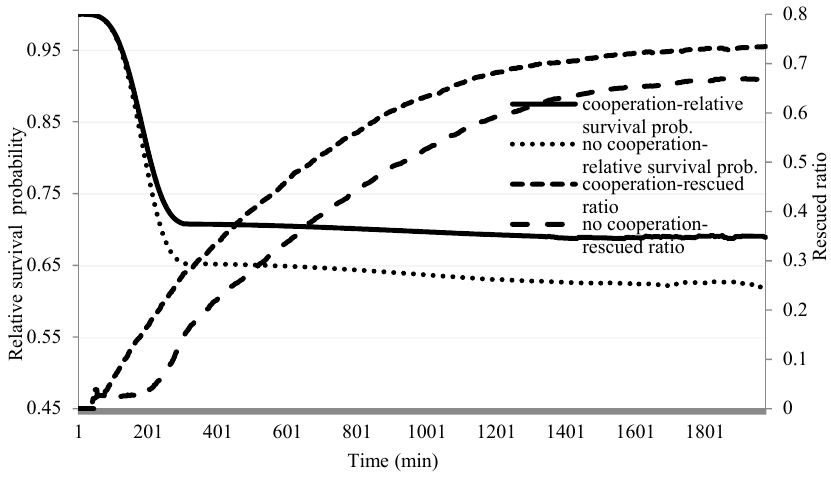
Figure 6. The average output results of 200 runs at every step in scenario “Serious”.